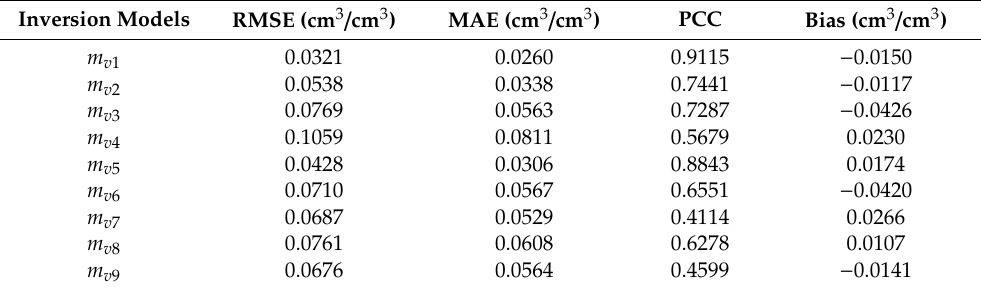
Table 5. RMSE, MAE, PCC, and bias between the measured and estimated soil moisture values based on the validation